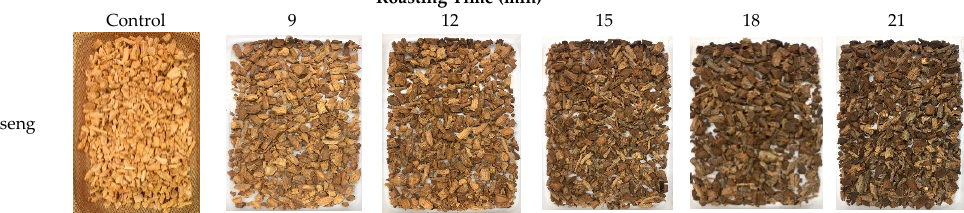
Figure 2. Appearance of dried ginseng root roasted for different times.